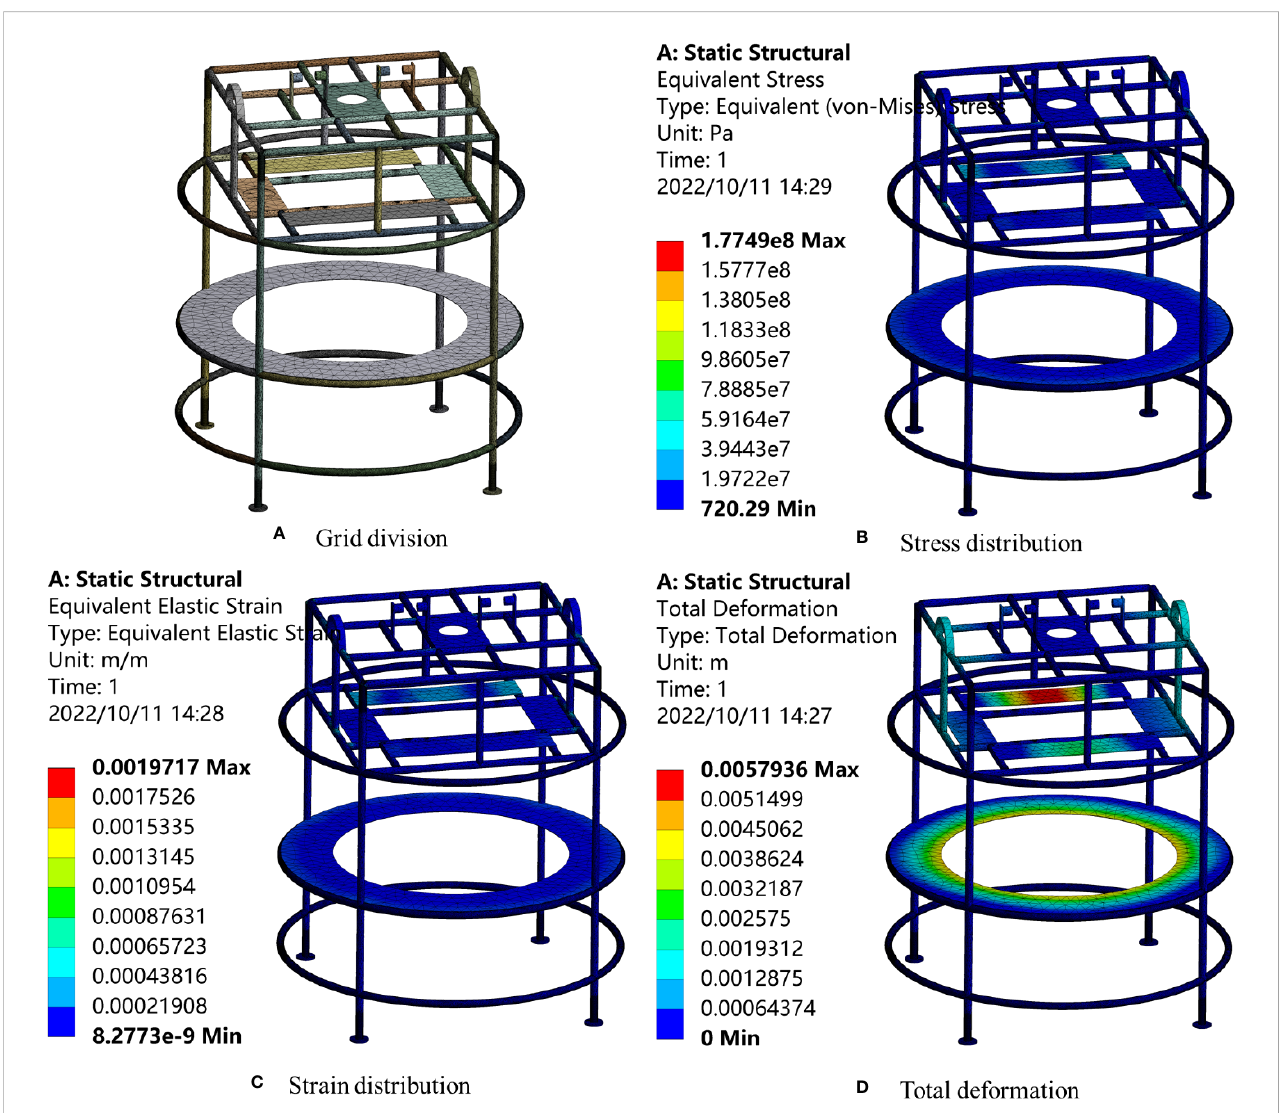
FIGURE 6 Static analysis of lander frame. (A) Grid division; (B) Stress distribution; (C) Strain distribution; (D) Total